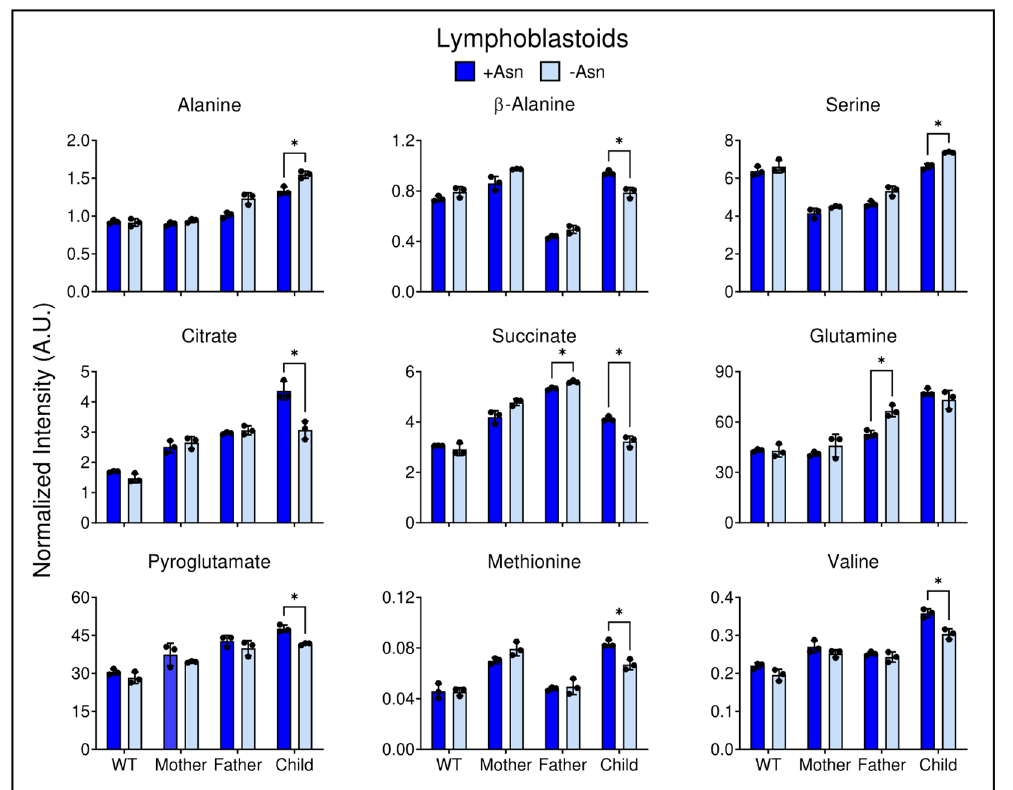
Figure 6. Di ff erential metabolite levels between +Asn and − Asn groups in LCL. Asn deprivation in ASNS-de fi cient cells leads to signi fi cant decrements in TCA cycle intermediates, anaplerotic substrates, and amino acids. All cell lines were tested as N = 3 biological replicates. The data are shown as means ± SD and statistical signi fi cance was established by two-way ANOVA analysis with Šidák multiple comparisons correction, represented as: (*) if p ≤ 0.05 compared between +Asn and − Asn groups for each cell line.